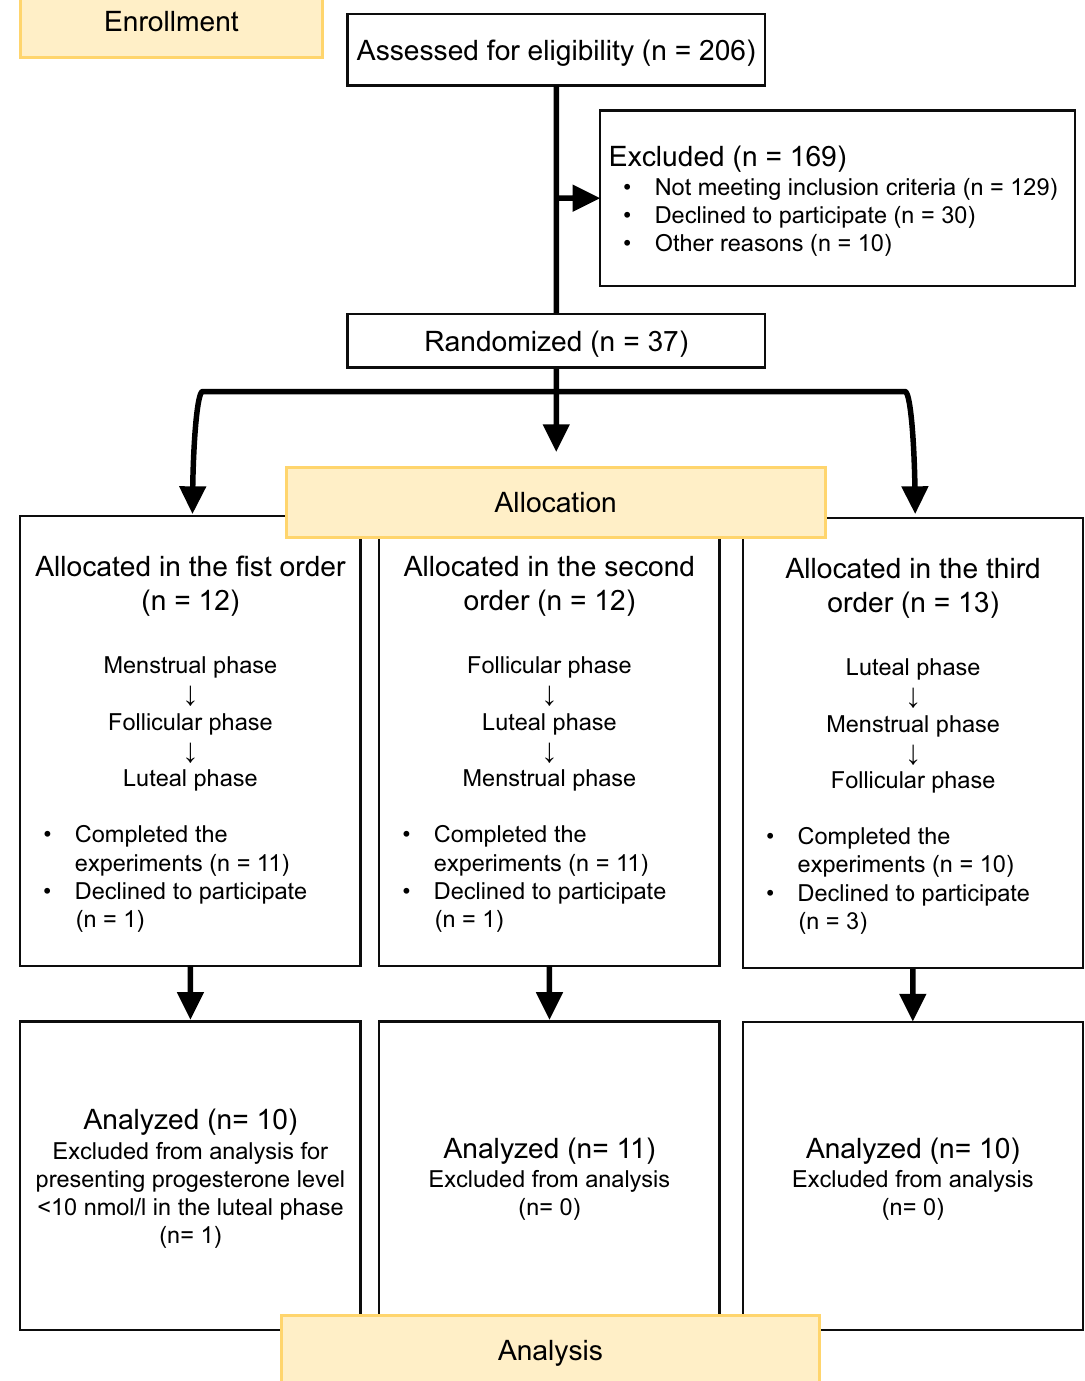
Figure 1. Flow diagram of the number of participants in enrollment, allocation and analysis phases of the